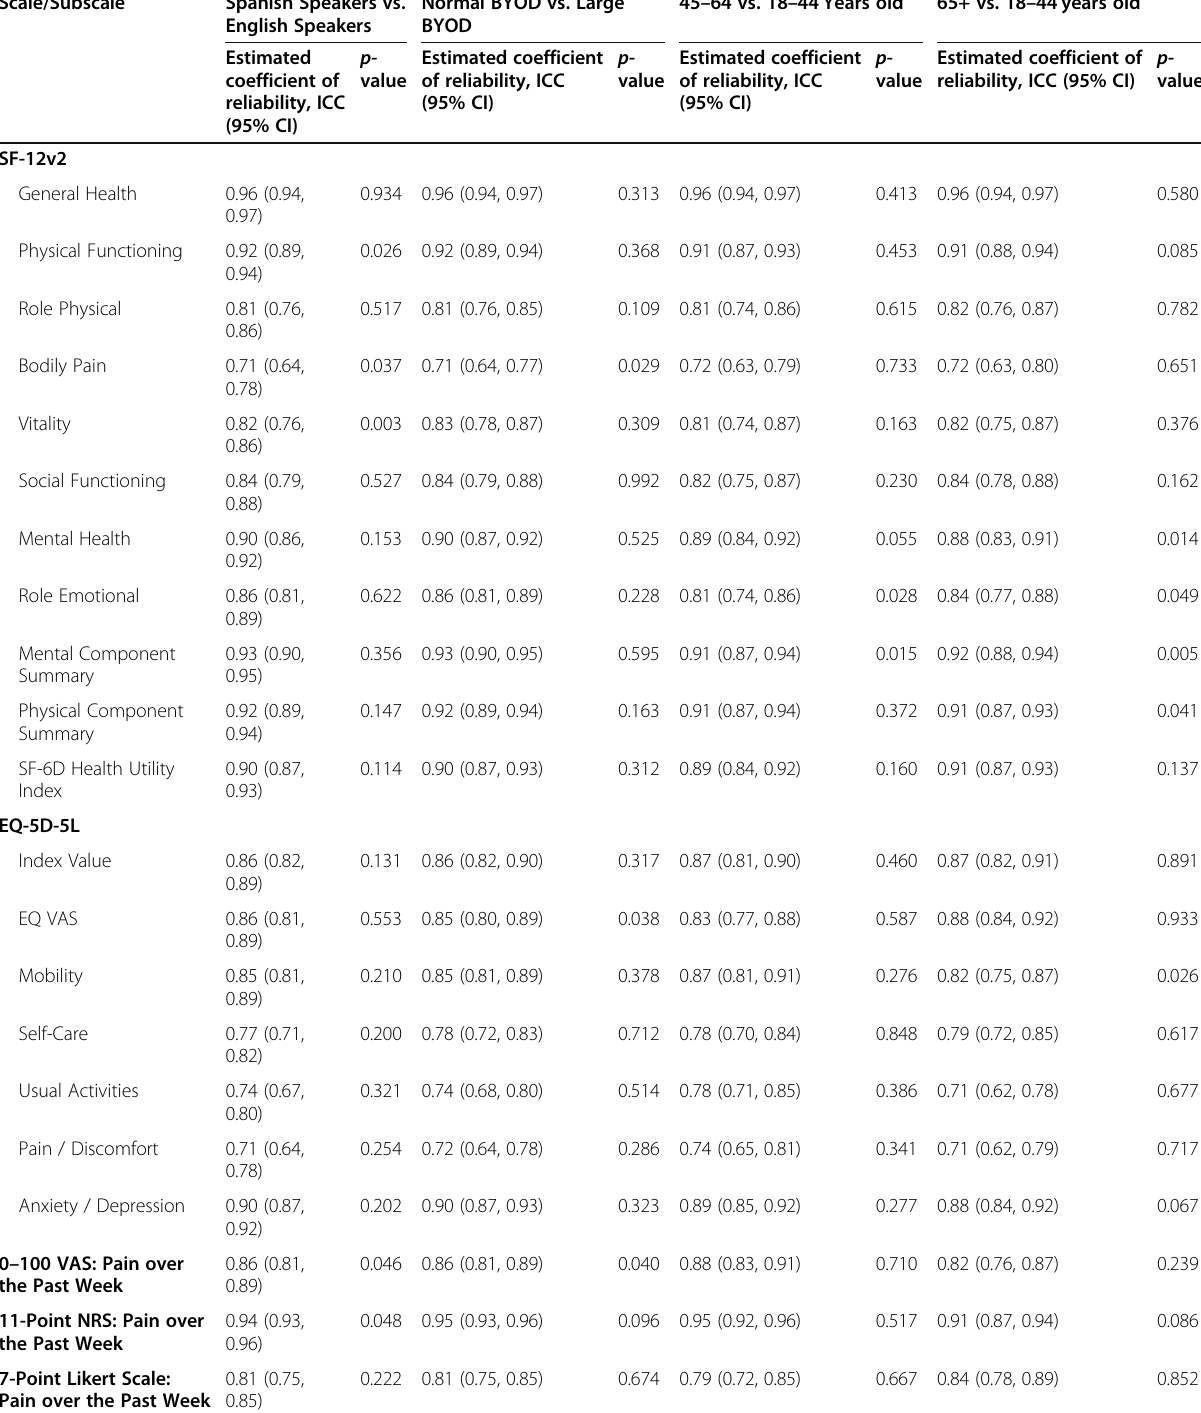
Table 4 Intraclass Correlations for covariate impacts (language, device size, and age) Scale/Subscale Spanish Speakers vs. English